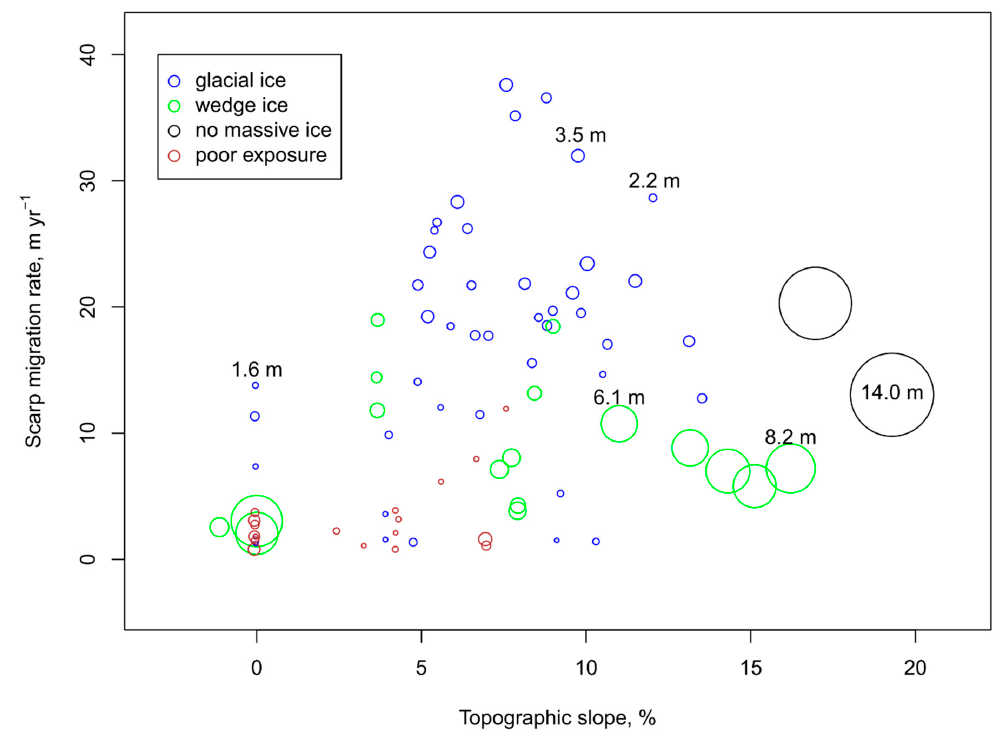
Figure 9. Scarp migration rate along the centerline vs. topographic slope at the scarp. The circle symbols are scaled to the escarpment height, with examples labeled with height in meters to illustrate the scale. Symbols are colored by the type of ground ice observed in the scarp exposures: blue—glacial ice; green—wedge ice, with or without glacial ice below; black—no massive ice observed in the exposure (slump NOAT265); and brown—poor exposures prevented examination of ground ice.